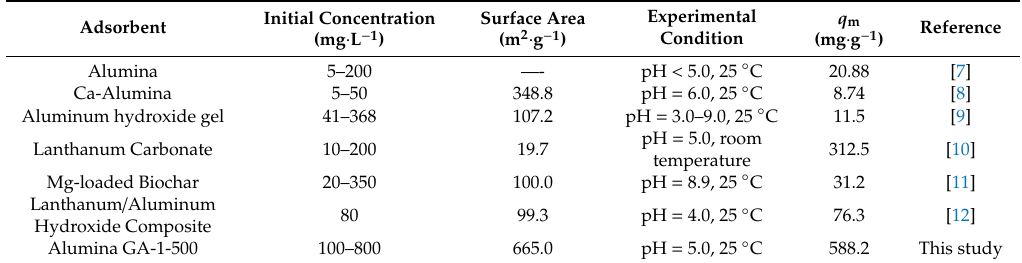
Table 3. Comparison of the phosphorus adsorption capacities of di ff erent